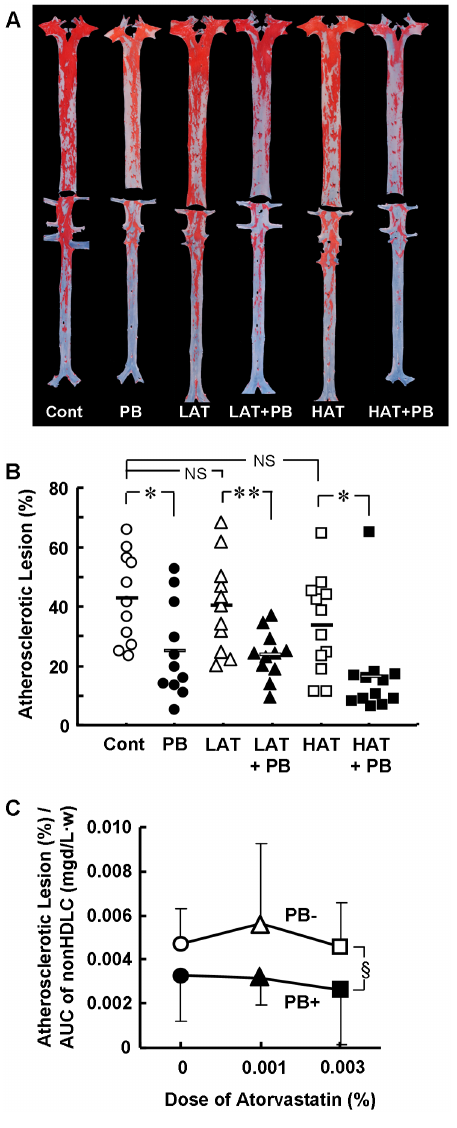
Figure 2. Effects of probucol and atorvastatin on atheroscle- rotic lesion areas. Representative images of whole atherosclerotic aortas are shown for each group (A). Atherosclerotic lesion areas (ALA) were stained with Sudan IV. Relative ALA of the whole aortas are shown (B). Relative ALA of the whole aorta corrected by the plasma non-HDL cholesterol (nonHDLC) is compared between 0.1% probucol-treated (PB + ) and -non-treated (PB 2 ) groups (C). Data are presented as mean 6 SD. There were 11 animals in the control (Cont, open circle), PB (closed circle), 0.001% atorvastatin (LAT, open triangle), and LAT + PB (closed triangle) groups, and 12 in the 0.003% atorvastatin (HAT, open square) and HAT + PB (closed square) groups. *p , 0.05; **p , 0.01 by unpaired t- test. NS, not significant by Dunnett’s test. 1 p , 0.01 by two-way ANOVA. standard curve generation or LDL dialyzed against 0.25 mM EDTA-4Na (pH 7.4)/PBS of each group for 30 minutes at room temperature and overnight in a refrigerator under protection from light; washed with washing solution; incubated with chicken anti- rabbit apolipoprotein B (apoB) immunoglobulin Y polyclonal antibody (1:1000 dilution) for 2 hours at room temperature under protection from light; washed with washing solution; incubated with labeled antibody (AP-AffiniPure Donkey Anti-Chicken IgY,